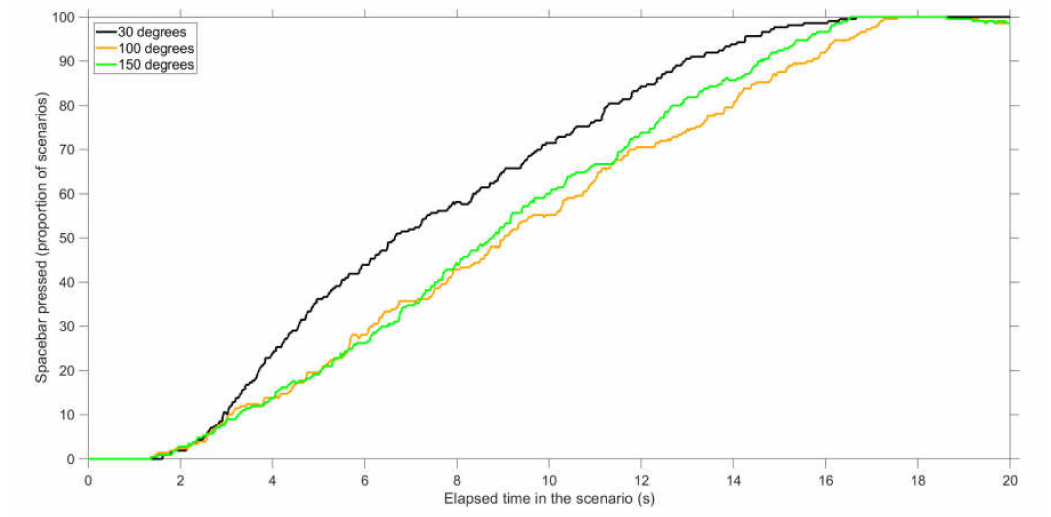
Figure 3. Percentage of participants who pressed the spacebar at that point in time during the scenario, for conflict scenarios. The proportion is calculated for 210 scenarios (35 participants × 6 scenarios per conflict